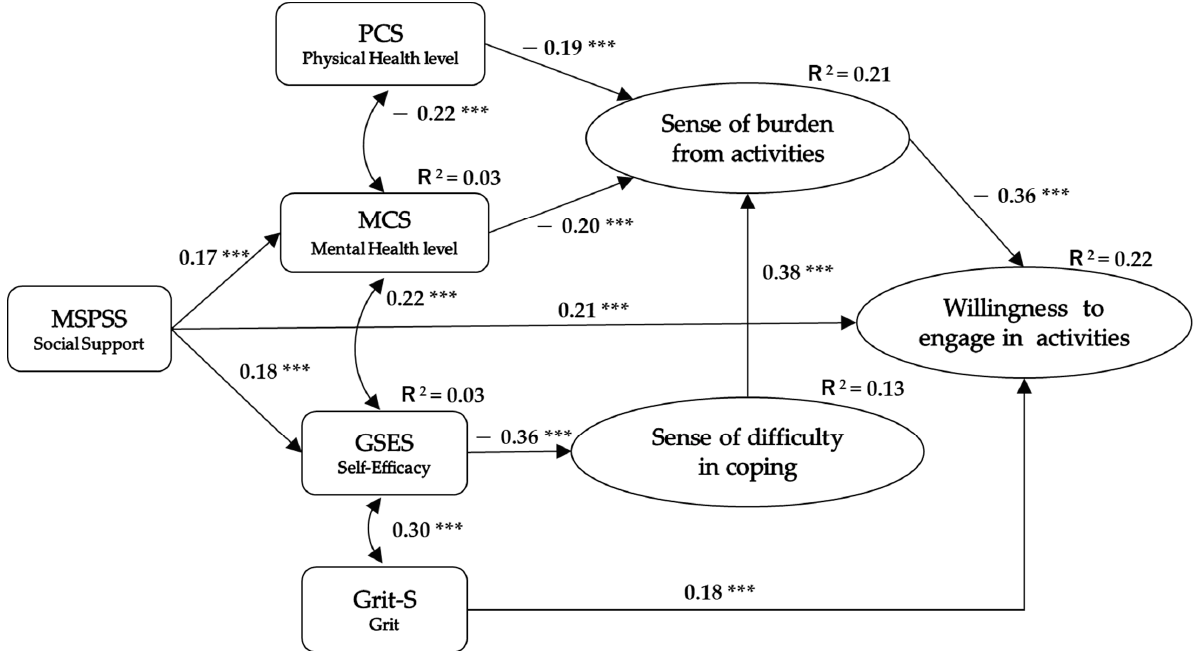
Figure 2. Relationship among factors related to willingness to engage in activities. Note: Arrows indicate regressions; numbers are standard partial regression coefficients. Double-headed arrows indicate correlations; numbers are partial correlation coefficients. R 2 : coefficient of determination. *** p < 0.001.